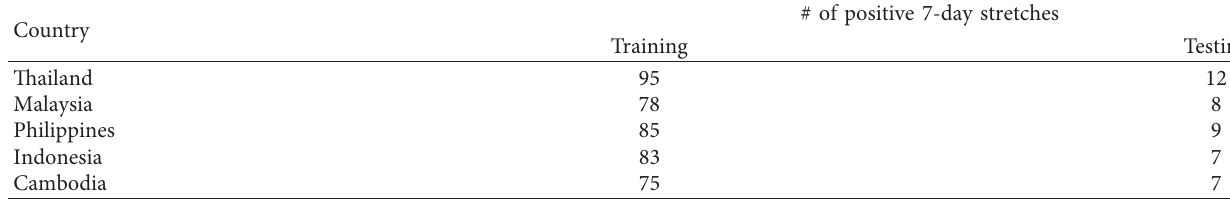
Table 2: Number of positive 7-day stretches in 778 weeks of our experiment on different countries.